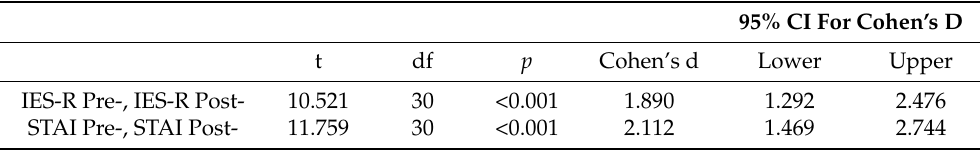
Table 4. Paired sample t -test—primary outcome measures.